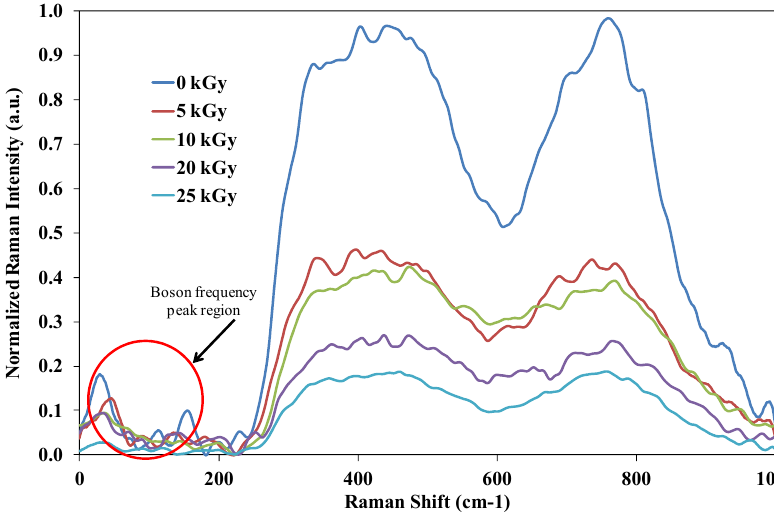
Figure 2. Raman spectra (at ambient temperature) of (TeO with different irradiation doses at x = 0.5% mol, y = 0.7%